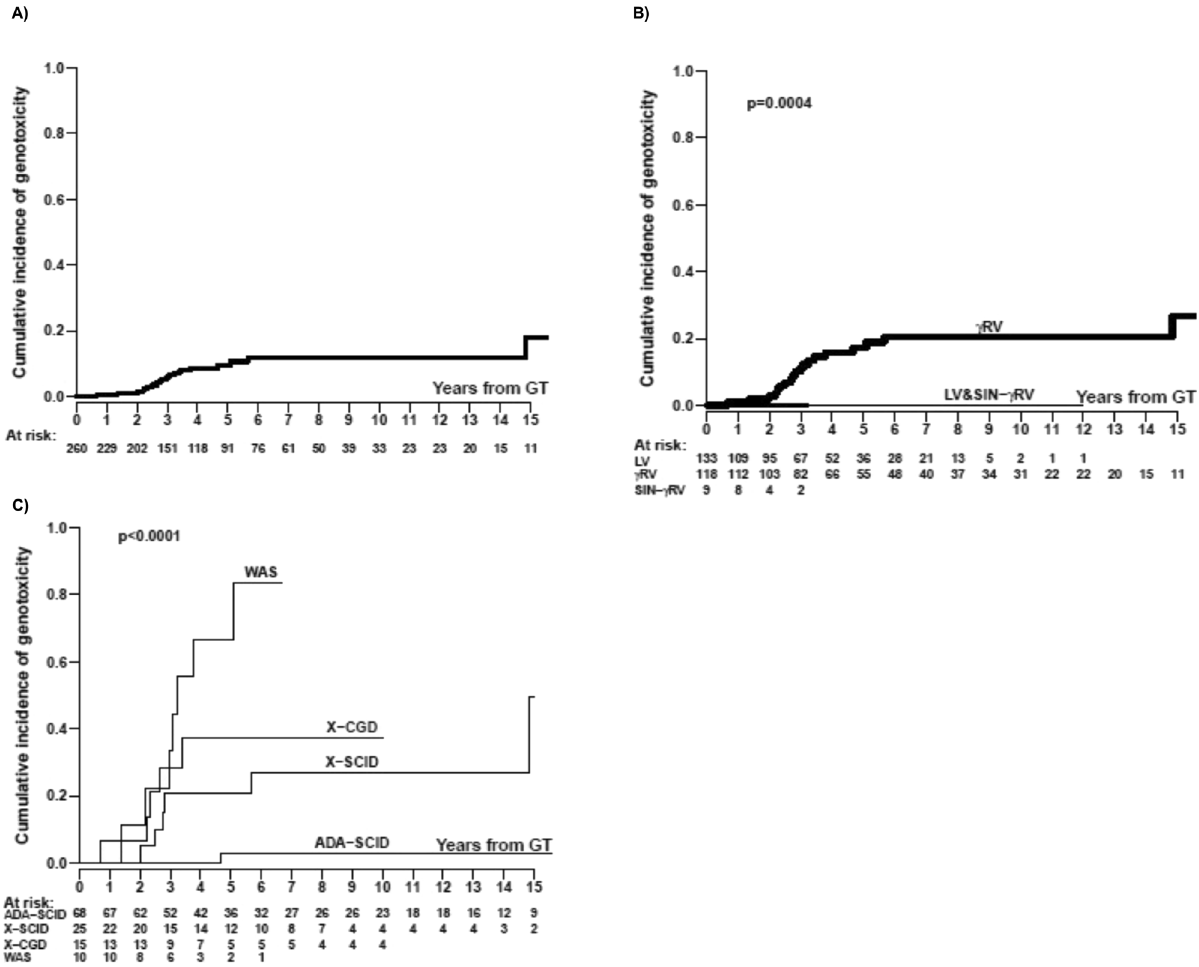
Fig. 4 Aalen-Johansen crude cumulative incidence rate of genotoxicity (A) overall and strati fi ed by (B) vector type and (C) disease using γ RV. The result of the Gray test (two-tailed) is also reported. Source data are provided as a Source Data fi